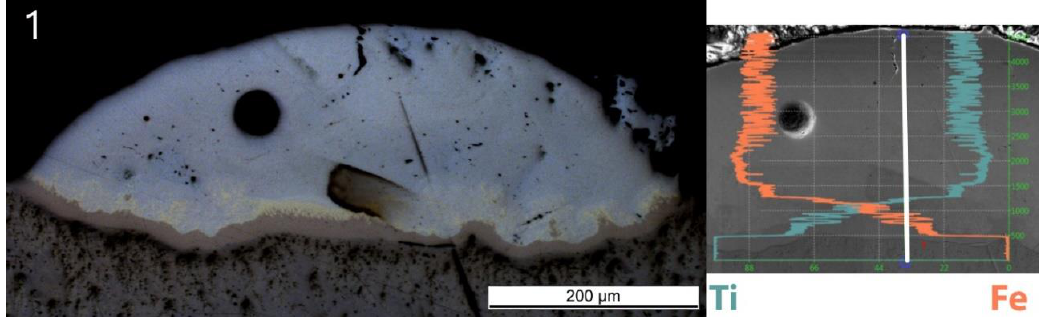
Figure 4. OM image of Sample Line_S_1 (left) and its energy-dispersive X-ray spectrometry (EDS) line scan result with the same scale (right). The scan was conducted along the white line. Vertical coordinate is the position on the scan line. Horizontal coordinate is the atomic concentration with 100% on the left. The cyan curve starting from 100% at the bottom (Ti substrate) is atomic concentration of Ti. The orange curve starting from 0% at the bottom is atomic concentration of Fe.